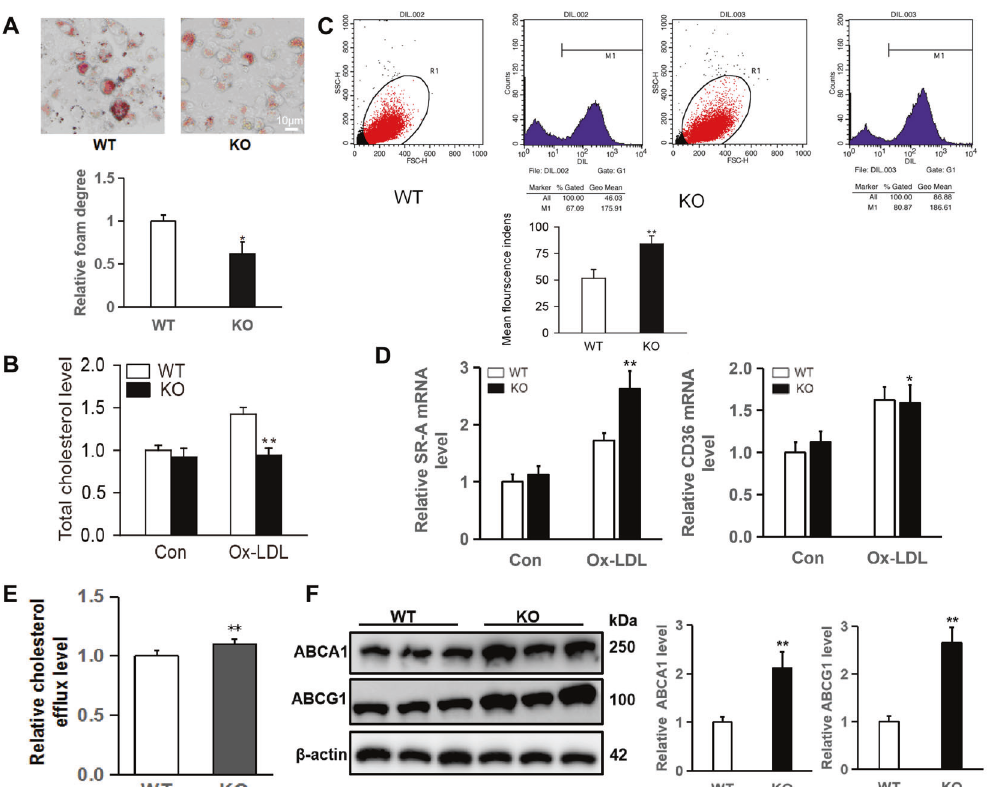
Fig. 4 Swiprosin-1 de fi ciency attenuated foam cell formation and cellular total cholesterol level and enhanced the lipid uptake and ef fl ux. A Representative images of primary peritoneal macrophages from swiprosin-1 − / − ( Swp − / − ) and wild-type (WT) mice stained with Oil Red O after stimulated with ox-LDL (40 μ g/mL) for 24 h (upper) and quantitative analysis of foamy macrophages (down). Data are presented as the mean ± SE; * P < 0.05, n = 3 per group. Scale bars are 10 μ m. B Total cholesterol levels in primary peritoneal macrophages of Swp − / − and WT mice after stimulated with ox-LDL for 24 h were compared. Data are presented as the mean ± SE; ** P < 0.01, n = 3 per group. C Dil-ox-LDL uptake by primary peritoneal macrophages from Swp − / − and WT mice was detected by fl ow cytometry. Data are presented as the mean ± SE; ** P < 0.01, n = 3 per group. D The SR-A and CD36 mRNA expression in primary peritoneal macrophages was quantitated by real-time PCR. Data are presented as the mean ± SE; * P < 0.05, ** P < 0.01; n = 3 per group. E The relative levels of cholesterol ef fl ux were compared. Data are presented as the mean ± SE; * P < 0.05, n = 6/group. F Representative Western blot for ABCA1 and ABCG1 expression in primary peritoneal macrophages (left) and densitometric analysis (right). β -Actin served as the loading control. Data are presented as the mean ± SE; ** P < 0.01; n = 3 per